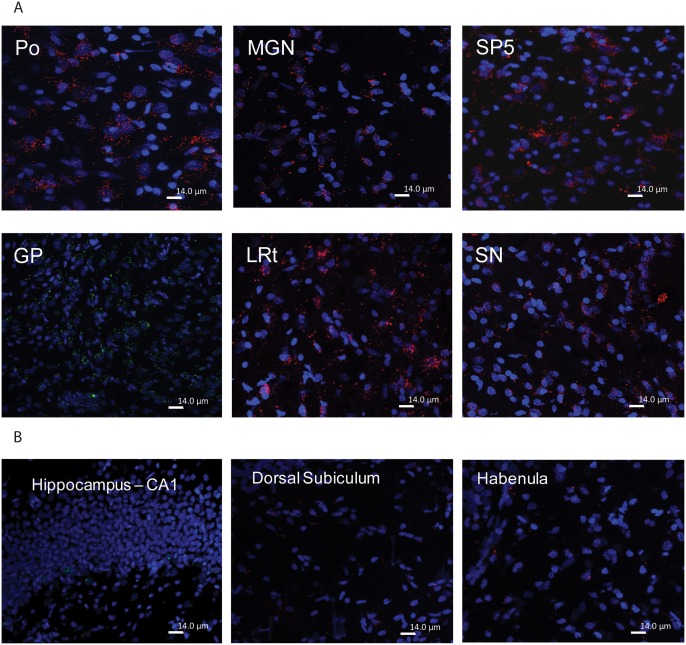
Prominent GBA-labeling by infused inhibody ABPs in motor related areas of the brain.(A) Strong red MDW941 labeling of brainstem motor related structures Po, SP5, Lrt, SN and MGN after i.c.v. administration. Example of green MDW933 labeling of GP (middle panel left). (B) Modest labeling of motivational and memory processing areas. Example of modest MDW933 labeling of hippocampus (left panel) and modest MDW941 labeling of dorsal subiculum, and habenular (middle and right panel).